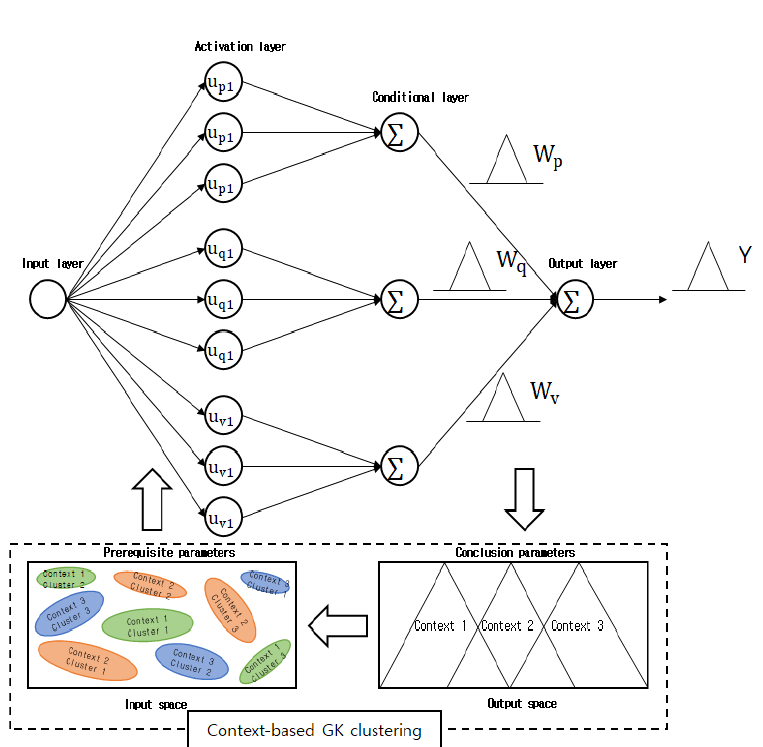
Figure 2. Structure of CGK-based fuzzy granular model.